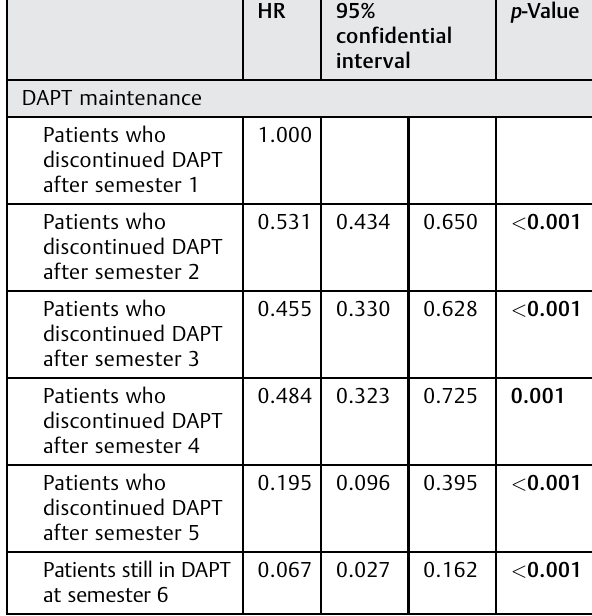
Table 4 All-cause mortality at 3 years in relation to DAPT